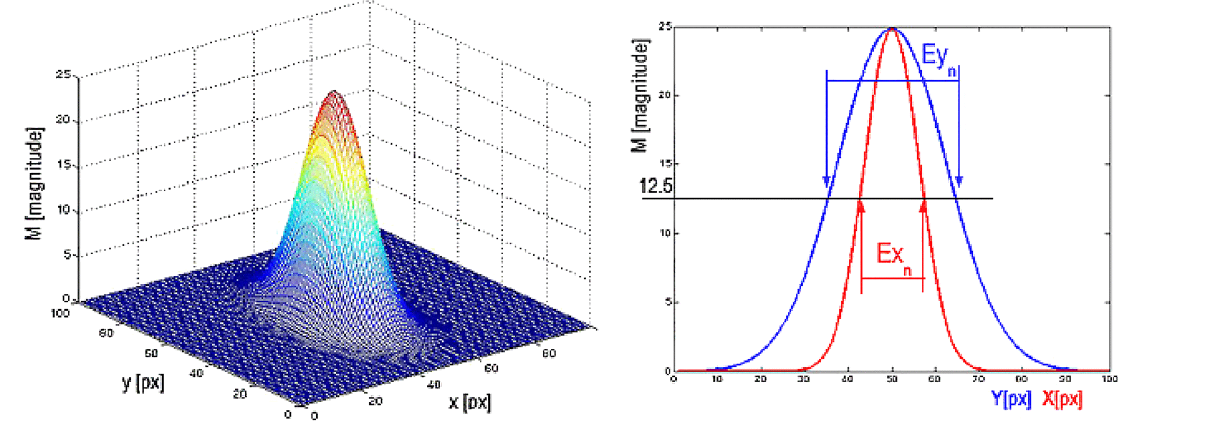
Fig. 8. Gaussian filter (left) – section of Gaussian filter (right). Ex and Ey represent the full width at half peak respectively in the x and y directions.